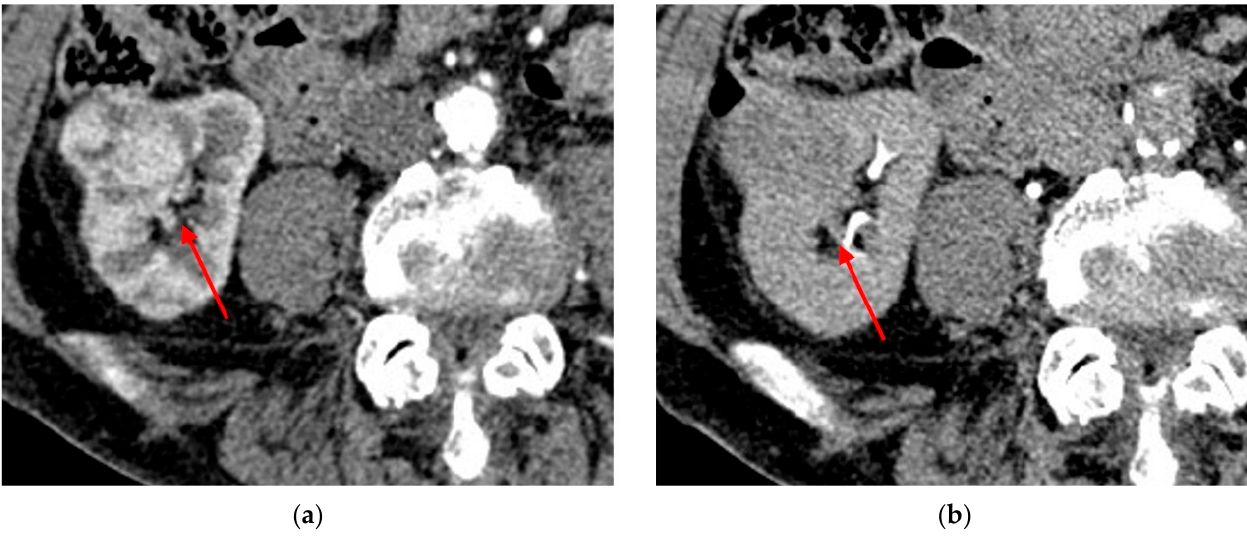
Figure 4 . Abdominal CT of ccRCC: ( a ) in the corticomedullary phase, the lesion demonstrates an intense contrast enhancement; ( b ) in the excretory phase, the contrast enhancement progressively decreases.